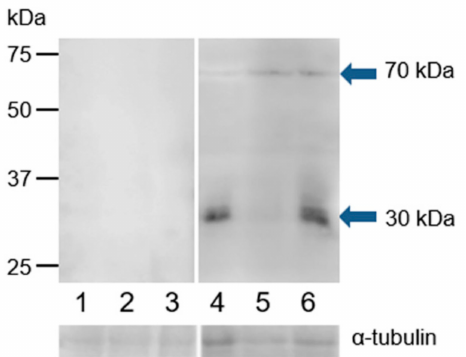
Figure 9. Reaction of anti-ESR1 (HC-20) with protein extracts from bull spermatozoa. Bull spermatozoa proteins were analyzed after separation by SDS-PAGE (12% gel) under reducing conditions followed by Western blotting with polyclonal antibody HC-20. 1, spermatozoa from the caput epididymis; 2, spermatozoa from the corpus epididymis; 3, spermatozoa from the cauda epididymis; 4, freshly ejaculated spermatozoa; 5, spermatozoa after in vitro capacitation; 6, spermatozoa after the acrosome reaction. The arrows indicate di ff erent protein isoforms of ESR1. The protein concentration in sperm samples was checked by α -tubulin detection.